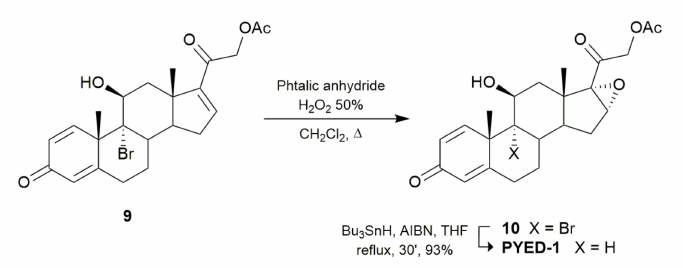
Figure 2. Synthetic transformations from brominated compound 9 to epoxide PYED-1.